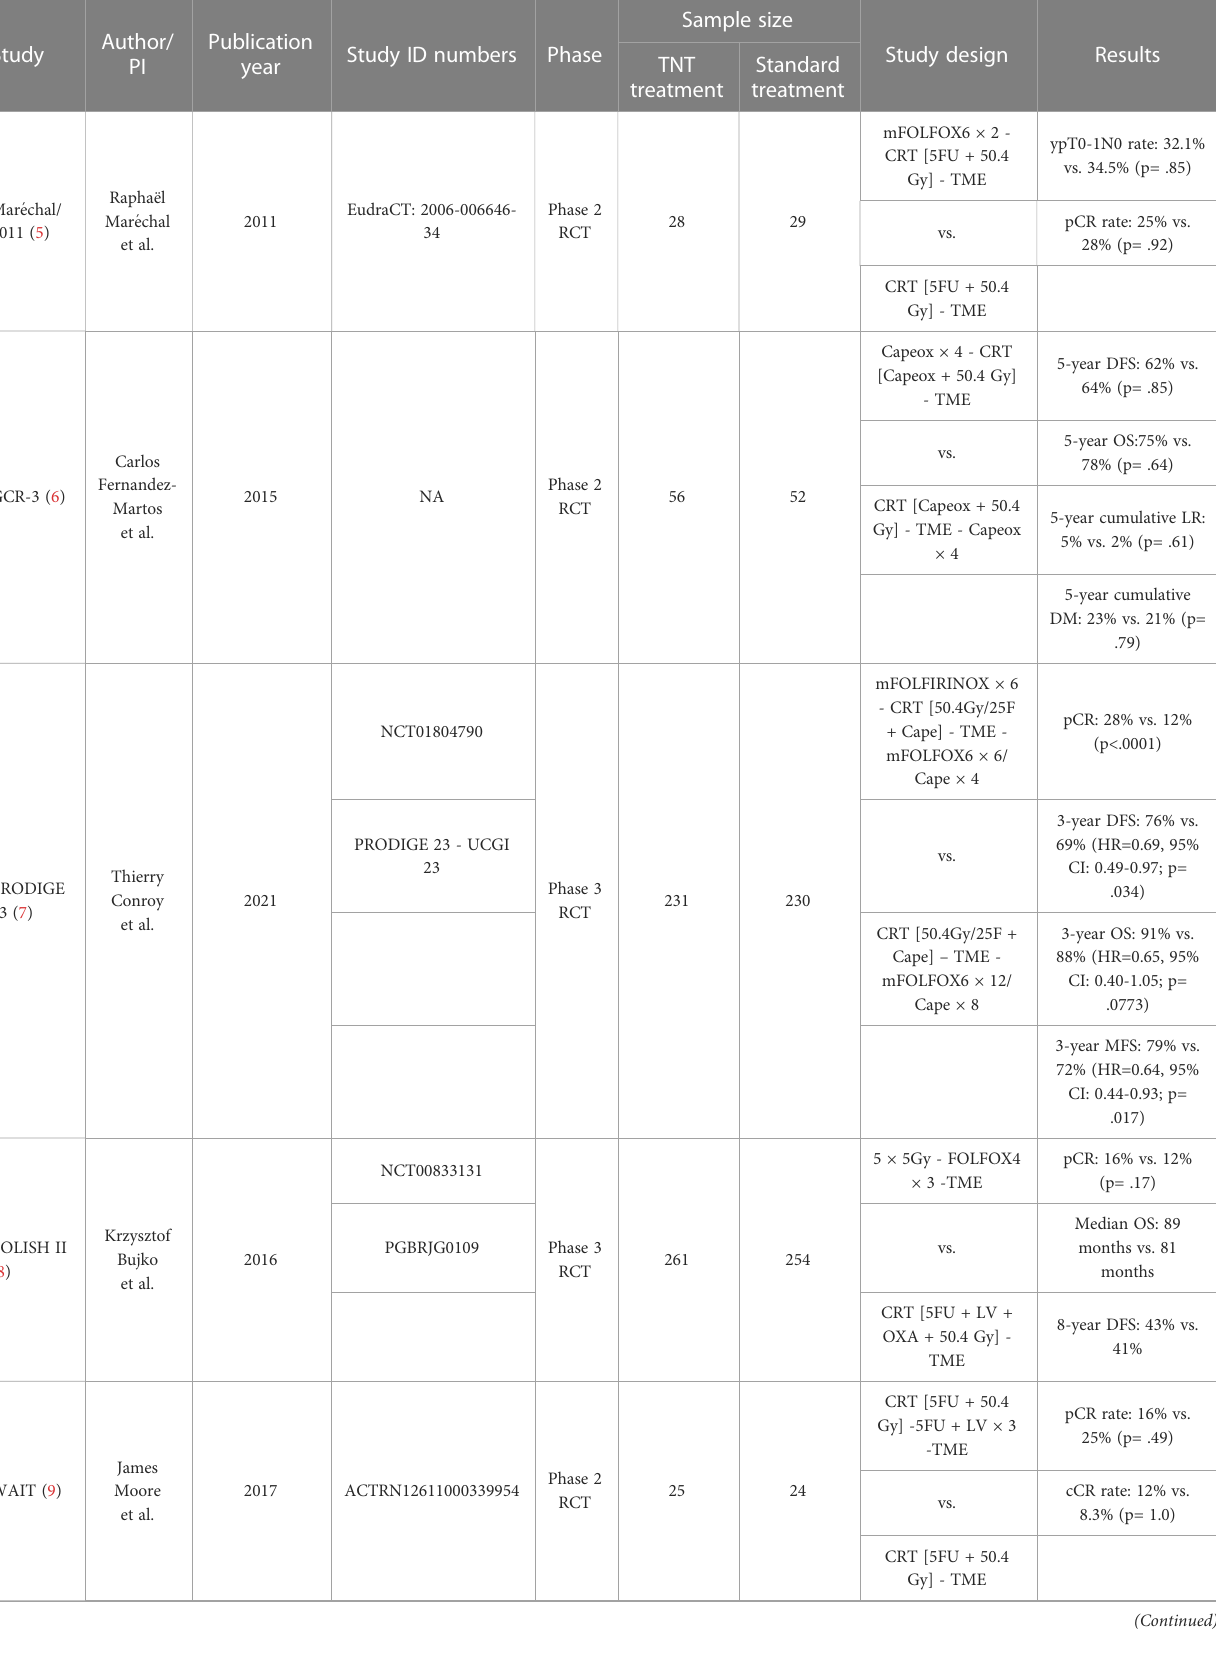
TABLE 1 Randomized clinical trials comparing total neoadjuvant treatment (TNT) with standard chemotherapy treatment (CRT) in